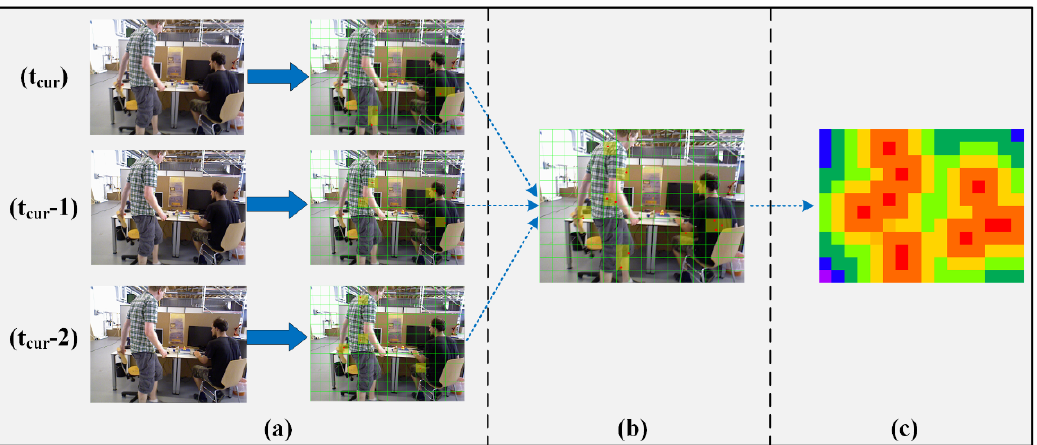
Figure 5. Regional dynamic degree acquisition. ( a ) corresponds to the dynamic point projection distribution of the last three frames. ( b ) corresponds to the projection distribution of dynamic points after merging the last three frames. ( c ) corresponds to the regional dynamic degree of the current frame.